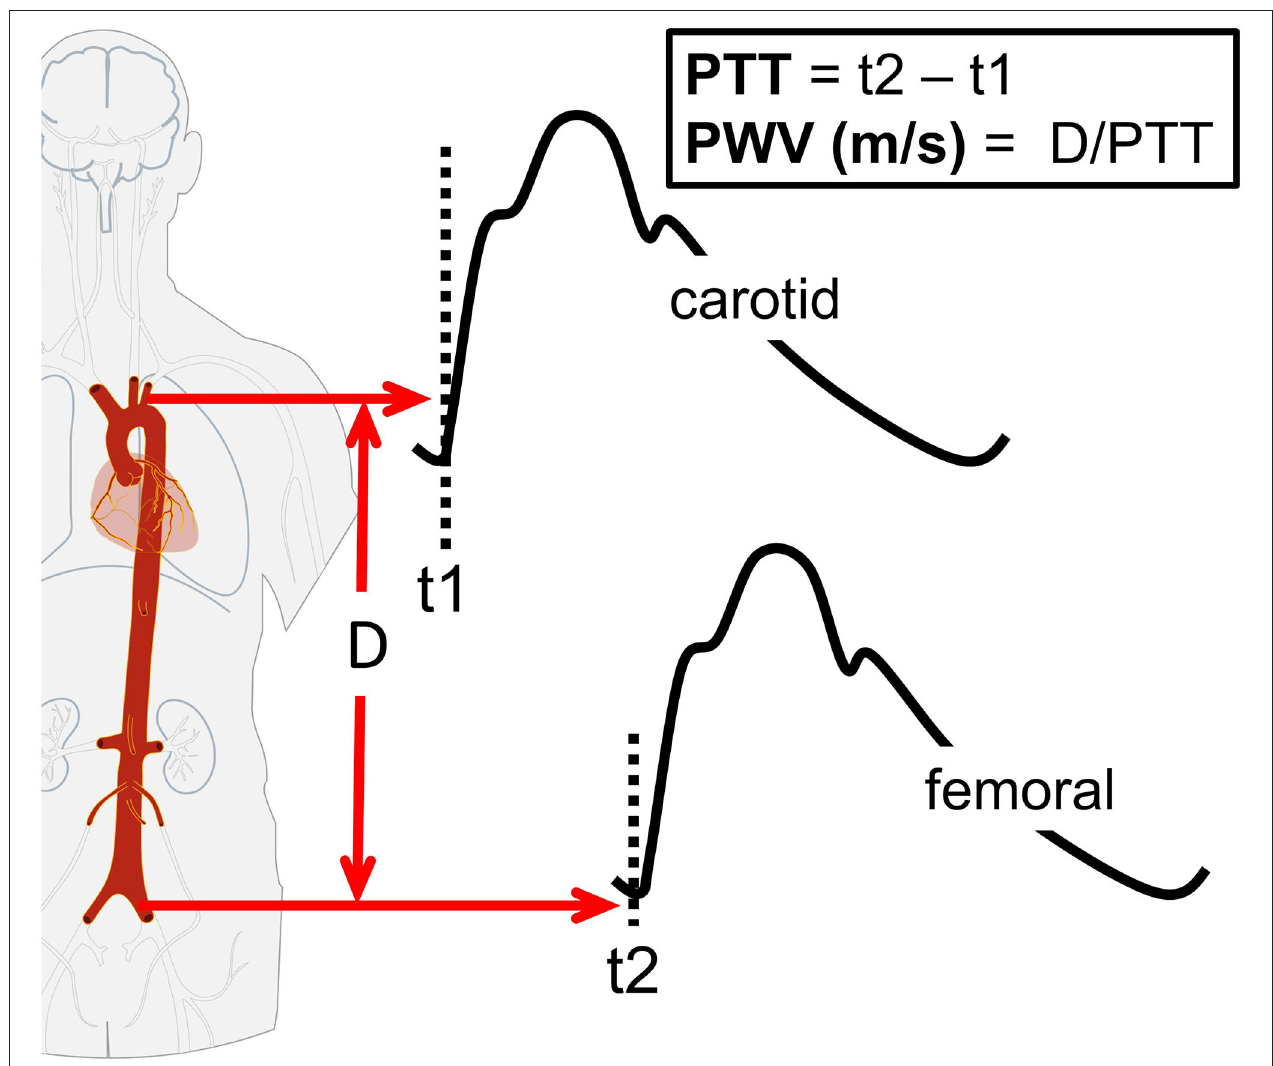
FIGURE 5 | Schematic of carotid-femoral pulse-wave velocity (cfPWV). The cfPWV is calculated by dividing path length (D) by pulse transit time (PTT). The PTT is estimated as the difference in time ( t ) between the proximal (carotid artery) pressure waveform ( t 1) and distal (femoral artery) pressure waveform ( t